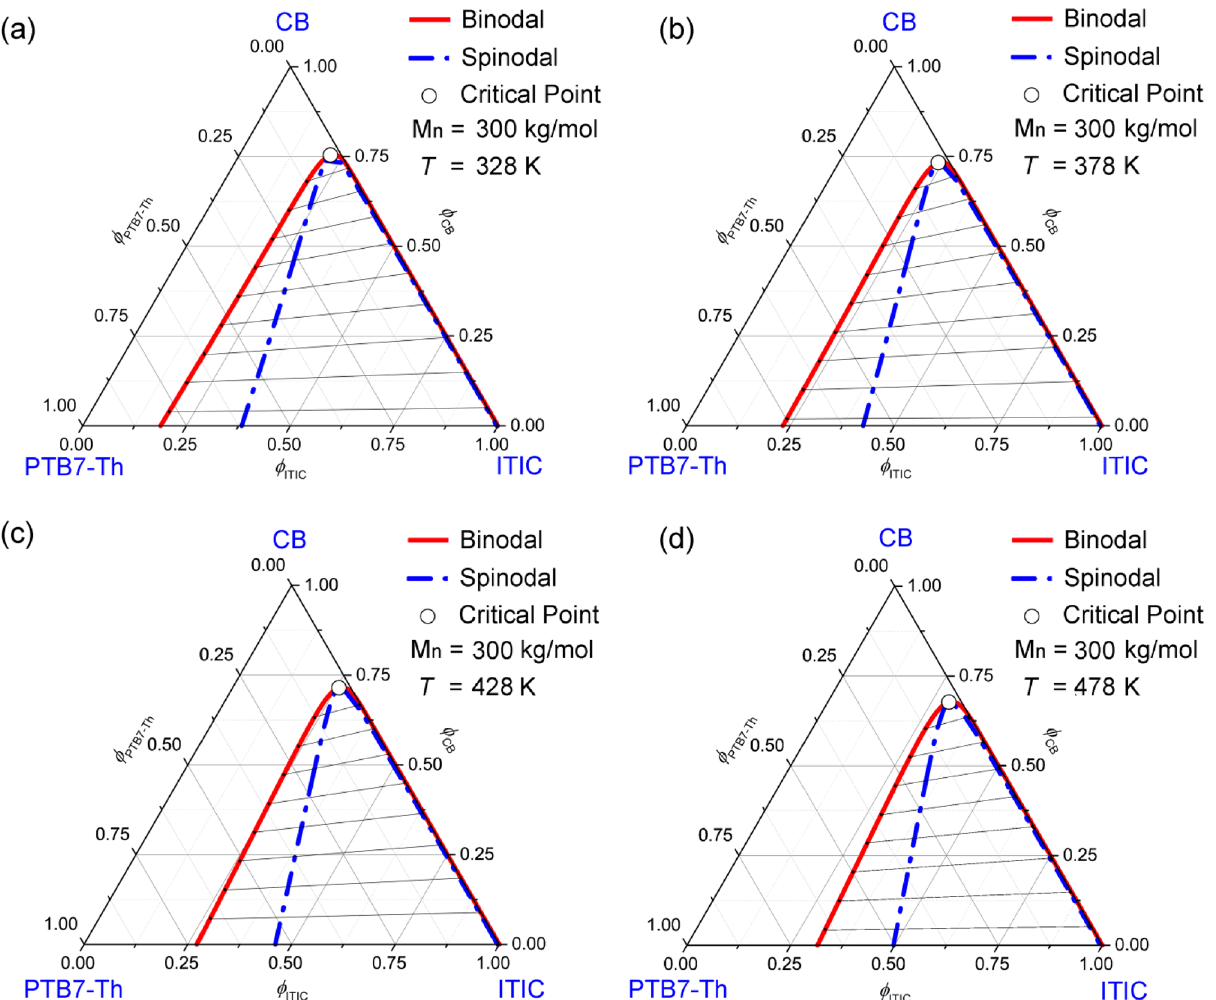
Figure 3. Phase diagrams for the ternary CB/PTB7-Th/ITIC system as a function of temperature: PTB7-Th’s M n = 300 kg/mol. ( a ) T = 328 K: χ 12 = 0.35 , χ 13 = 1.16 , and χ 23 = 1.31 . ( b ) T = 378 K: χ 12 = 0.35 , χ 13 = 1.05 , and χ 23 = 1.18 . ( c ) T = 428 K: χ 12 = 0.35 , χ 13 = 0.97 , and χ 23 = 1.09 . ( d ) T = 478 K: χ 12 = 0.34 , χ 13 = 0.91 , and χ 23 = 1.01 . Here, PTB7-Th’s M n = 300 kg/mol, s = 0.000389, and r =